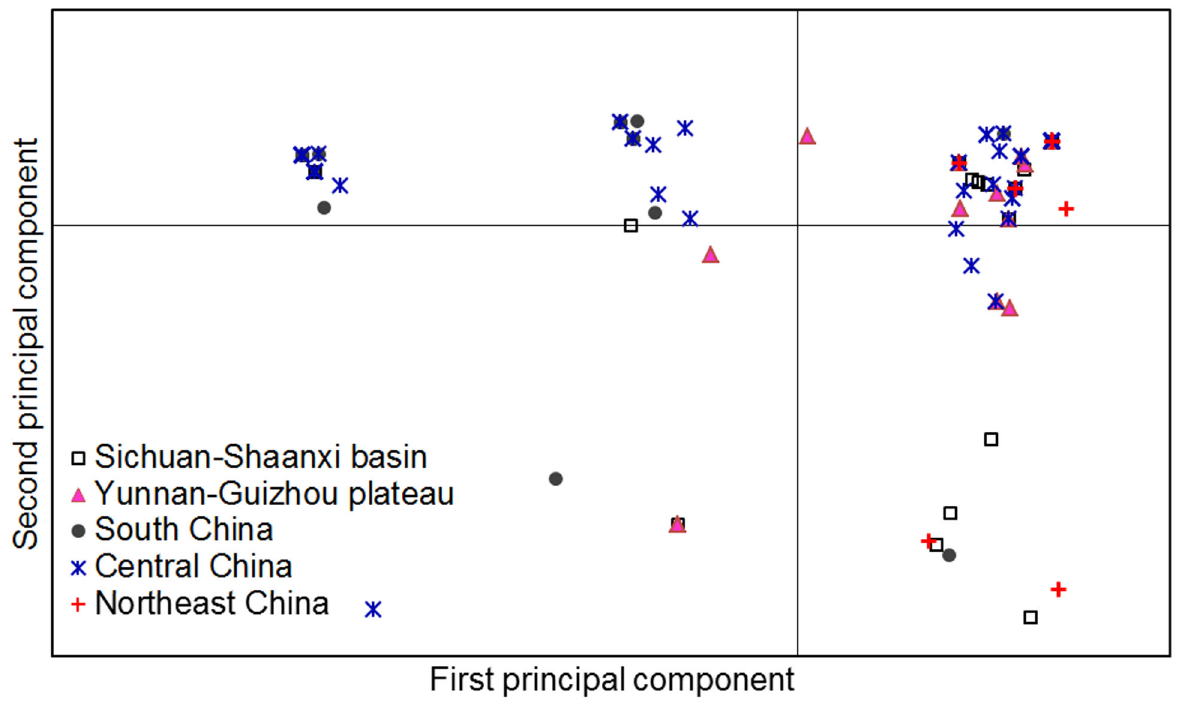
Figure 4. Principal component analysis (PCA) for 162 individual isolates from five major rice-growing areas in China. Individuals within the same population are marked using the same symbols. The first and second principal coordinates account for 41.6% and 23.0% of the variation, respectively. Note that individuals from a population may have separated and gathered with individuals from another